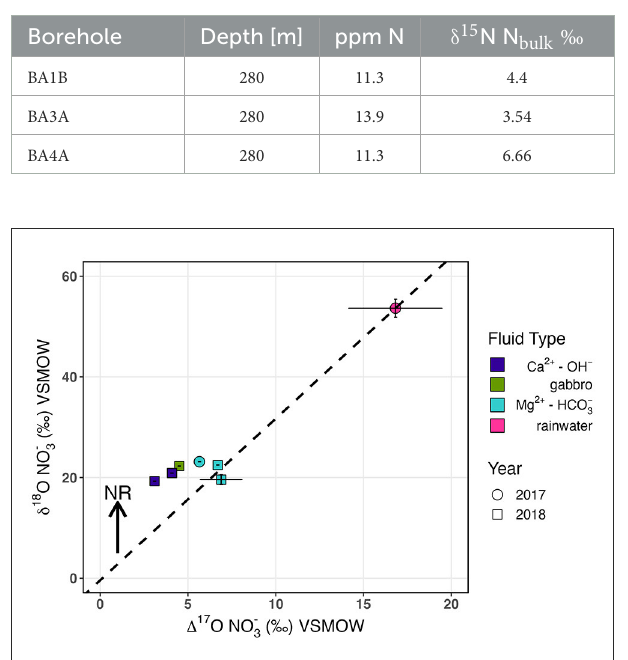
FIGURE4 2 + -HCO − δ 18 O vs. 1 17 O of NO − 3 fluids (blue) plot on a 3 . Mg theoretical mixing line with rainwater (pink) calculated for simple mixing of estimated end-member nitrified NO − 3 ( δ 18 O of − 0.4 ‰ and 1 17 O of 0 ‰ ). NO − 3 reduction would lead to increased δ 18 O with no change in 1 17